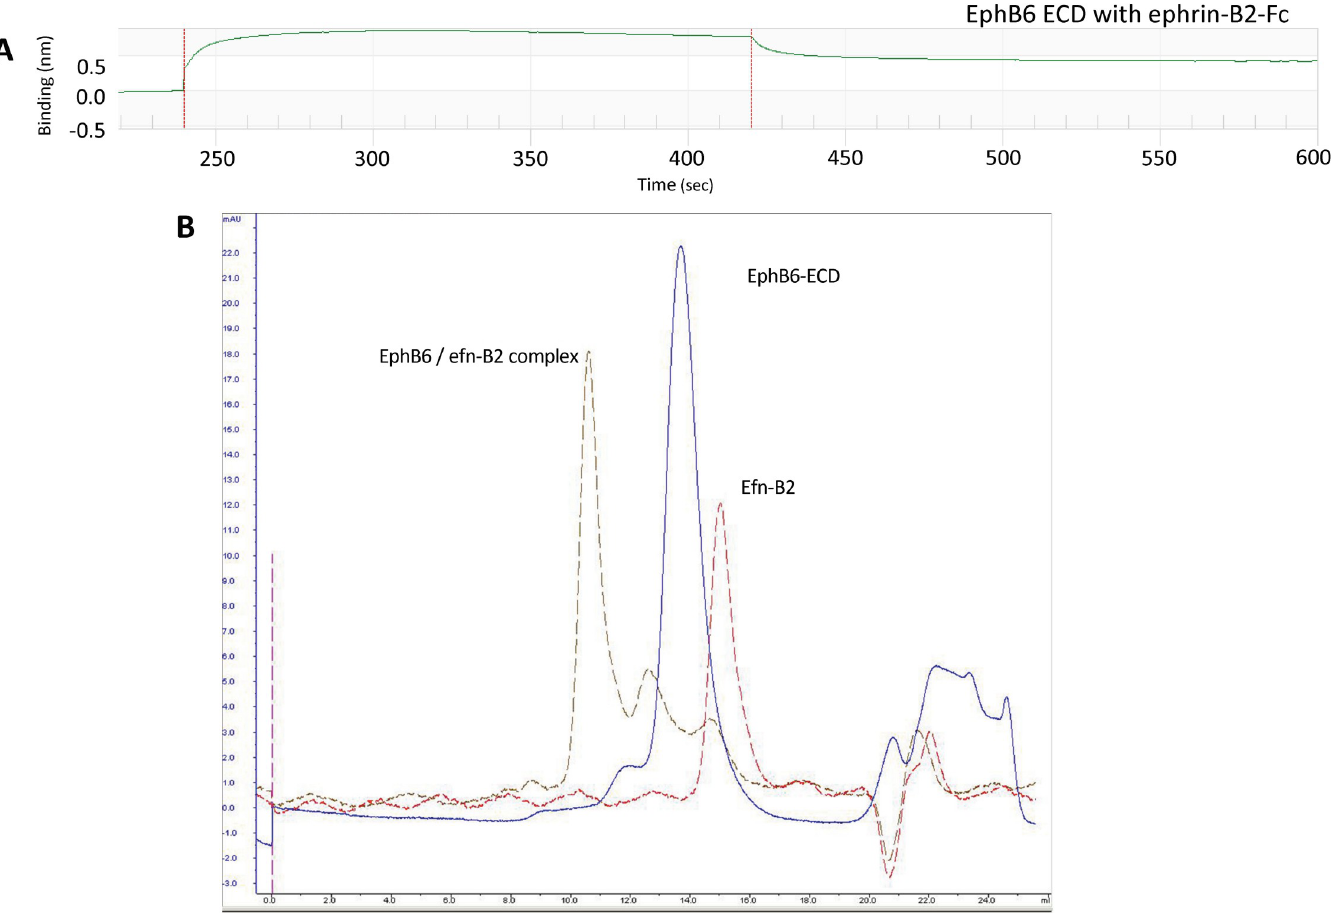
Fig 3. Binding of the EphB6-ECD to the ephrin-B2-Fc ligand. (A) EphB6-ECD binds to ephrin-B2-Fc with a K d value of 8.85 E -8 M as measured on a Blitz instrument; (B) Size-exclusion FPLC on a Superdex200 column reveals a 1:1 stoichiometry for the EphB6-ECD/ephrin-B2 complex.